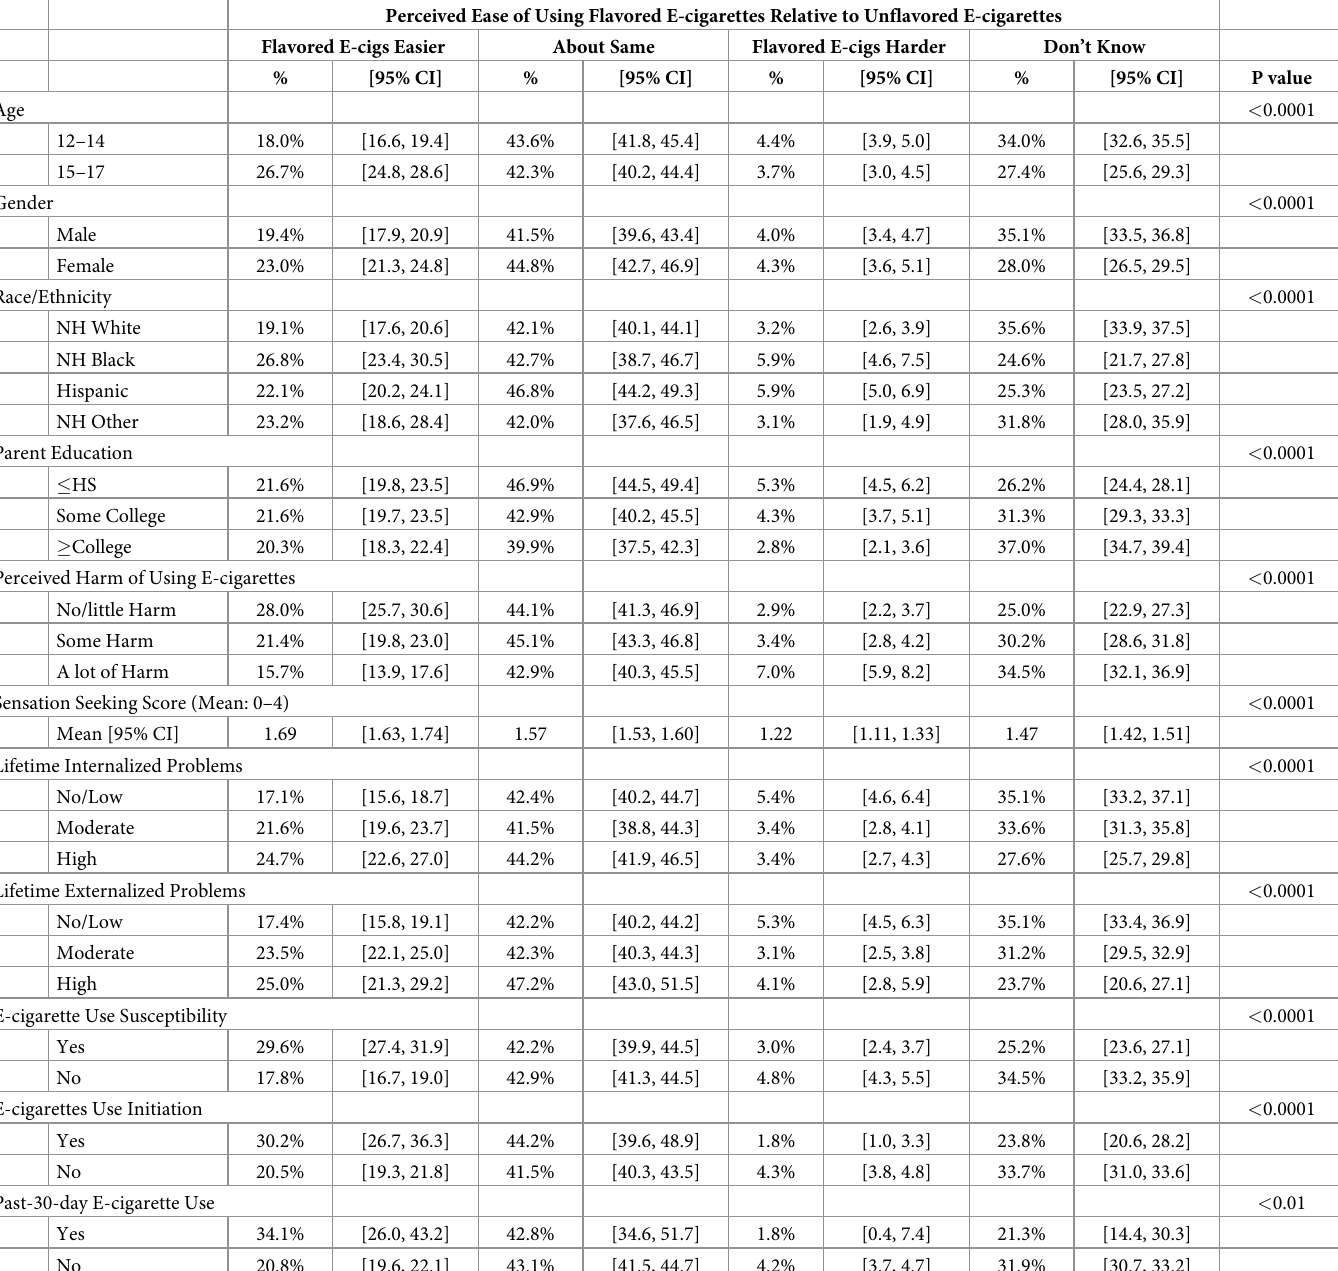
Table 1. Demographic and psychosocial covariates, perceived ease of using flavored e-cigarettes compared to unflavored e-cigarettes, and e-cigarette use outcomes —PATH Study youth (aged 12–17) wave 1 and 2 surveys (n = 6,983). Perceived Ease of Using Flavored E-cigarettes Relative to Unflavored E-cigarettes Flavored E-cigs Easier About Same Flavored E-cigs